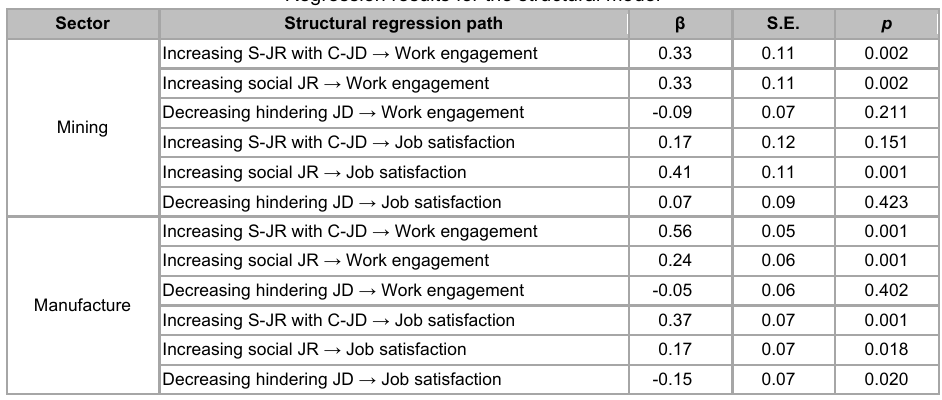
Regression results for the structural